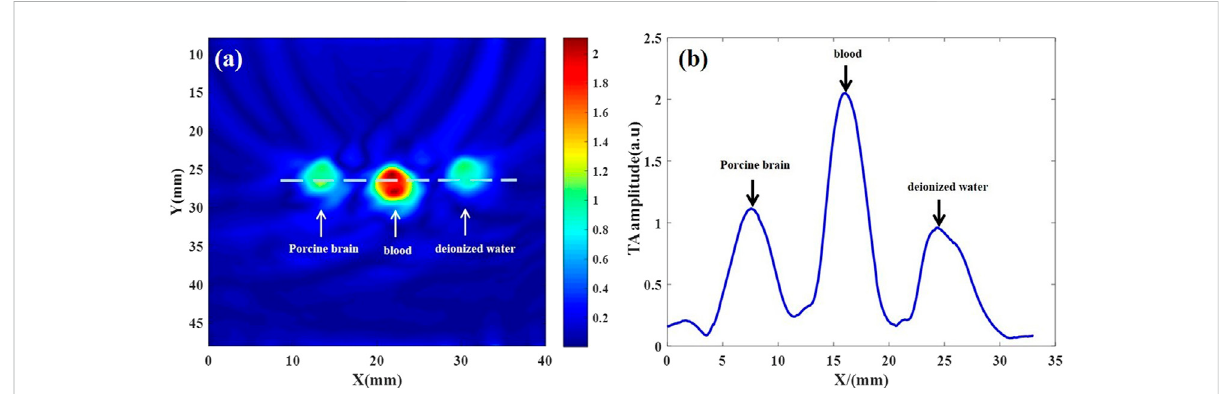
FIGURE 2 Thermoacoustic imaging of fresh ex vivo porcine brain, blood and deionized water. (A) Thermoacoustic image of ex vivo porcine brain, blood and deionized water. (B) The one-dimensional distribution curve of relative thermoacoustic signal amplitude along the white dashed line shown in (A) .